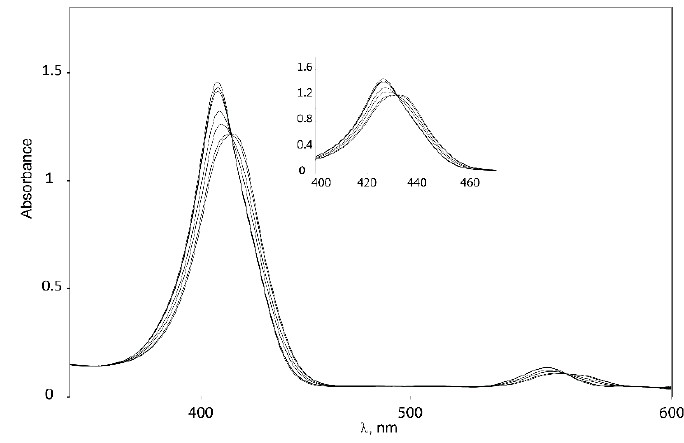
Figure 6. Isosbestic points for binding of 1,6-diaminohexane 21 to Z- 1 .